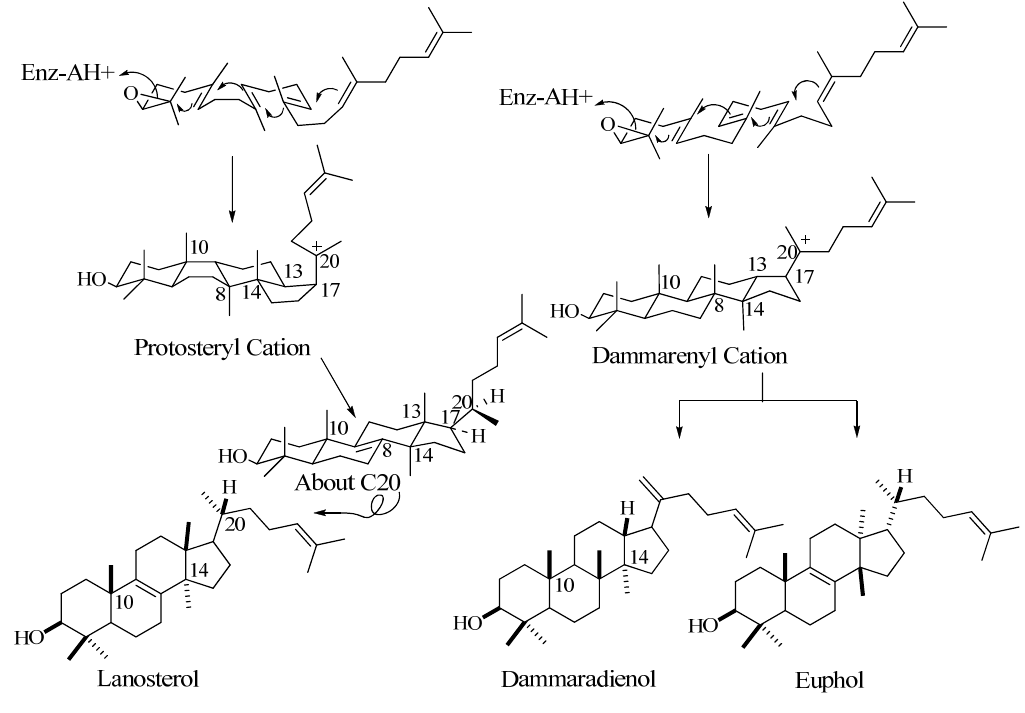
Figure 2. Cyclization of 2,3-oxidoqualene to sterols and